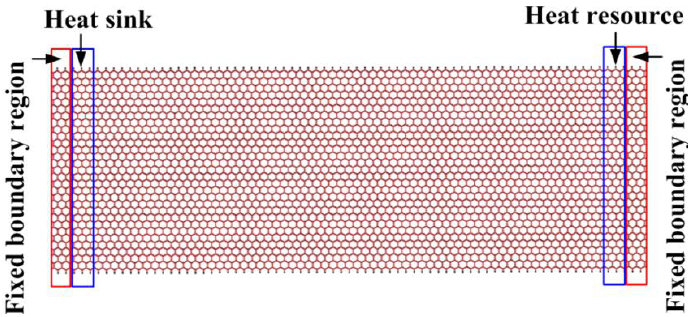
Figure 1. The MDs model for the simulation of thermal conductivity of